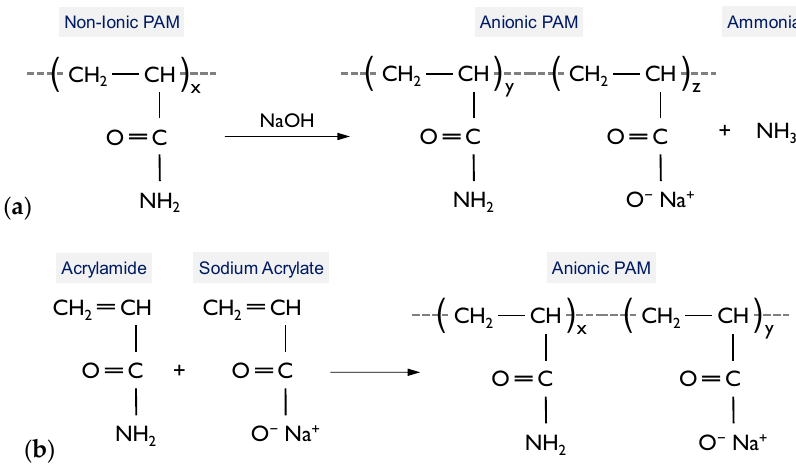
Figure 2. Pathways to anionic PAM formation: ( a ) Hydrolysis [52]; and ( b ) Copolymerization [52].